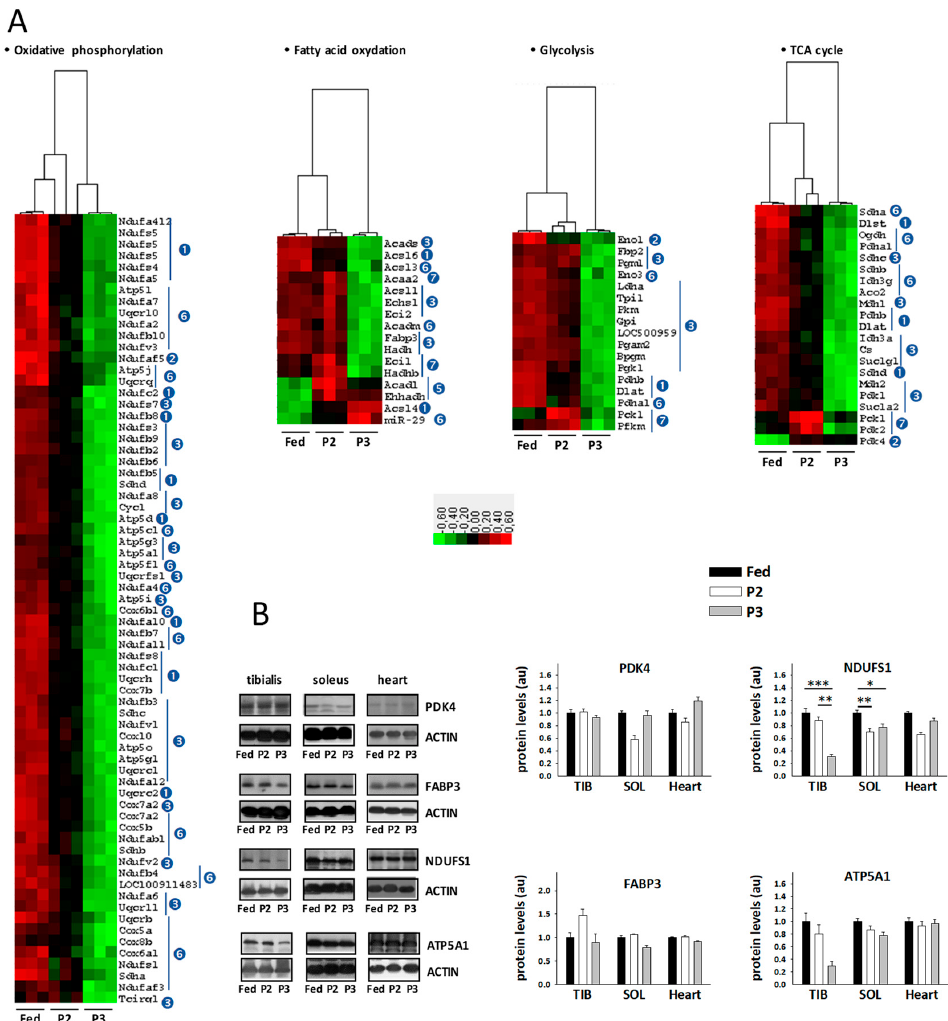
Figure 4. Changes related to energy/fuel metabolism in tibialis anterior muscle of rats during prolonged fasting. ( A ) Heatmaps showing differentially abundant transcripts between fed, phase 2 (P2), and phase 3 (P3) animals ( N = 3/group). Red, black, and green boxes represent downregulated, intermediate, and upregulated genes, respectively. Legend for numbers in blue circles, which indicate when mRNA levels were significantly changed (ANOVA and Tukey p -values < 0.001) is given in Figure 2B. ( B ) Representative Western blots and densitometry data for muscle proteins (means ± SEM, N = 5/group). The values in fasted animals were normalized to those in fed rats that were assigned an arbitrary value of one. * p -value < 0.05, ** p -value < 0.01, *** p -value < 0.001 (one-way ANOVA and Tukey tests).